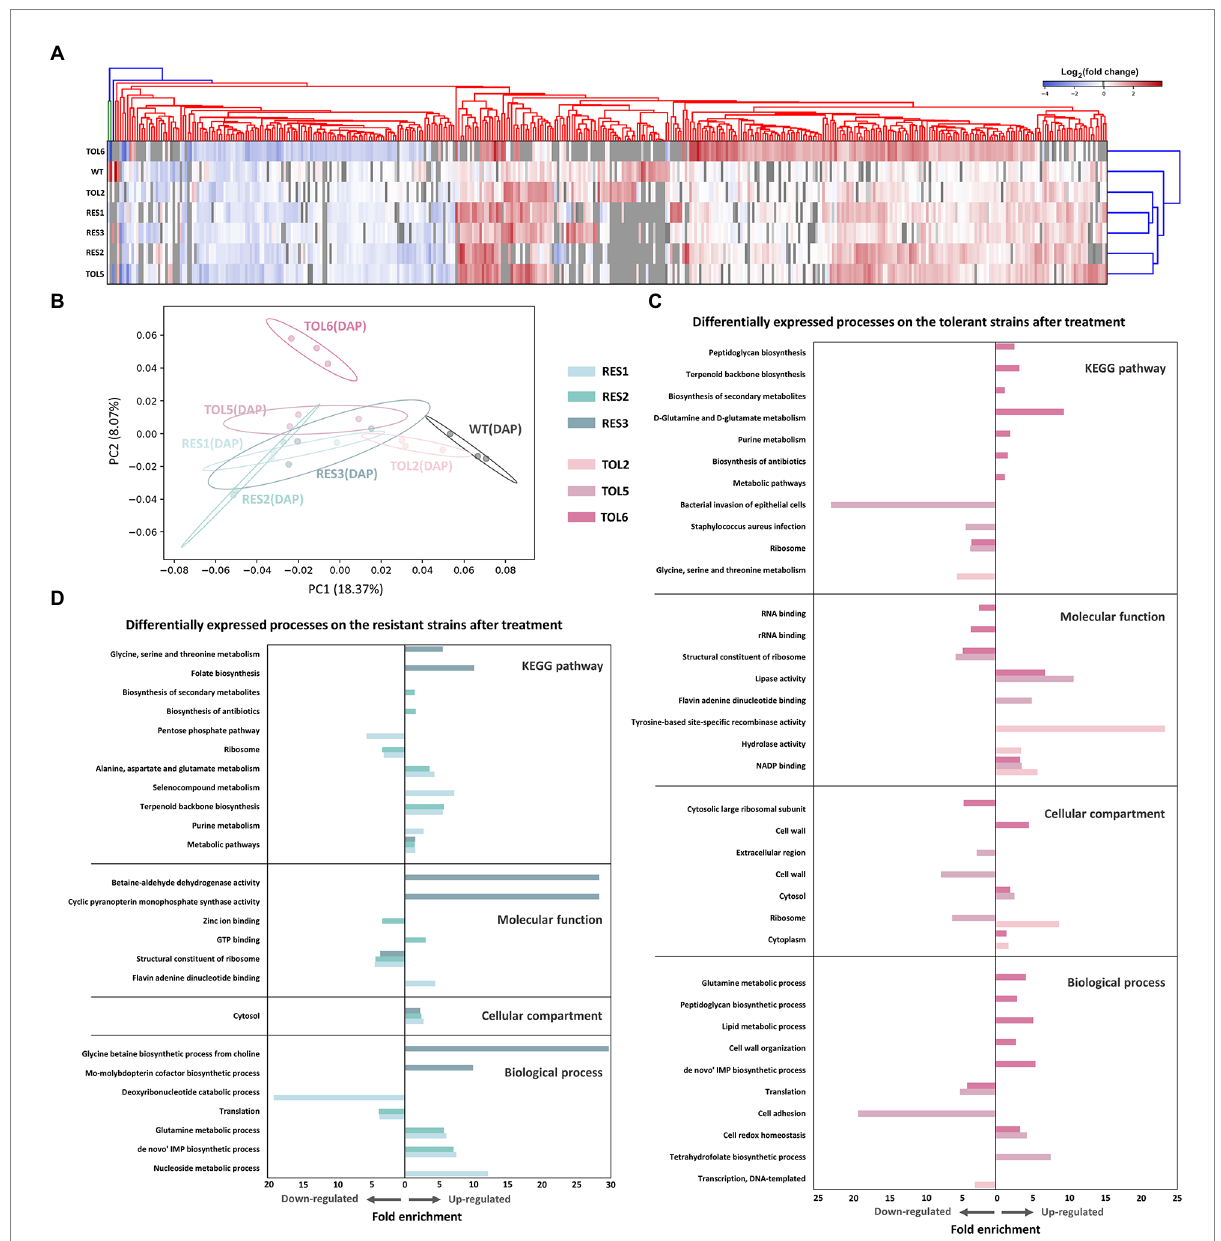
FIGURE 3 Proteomic response of the tolerant/resistant strains and the ancestral strain upon daptomycin treatment. (A) Heatmap of the DEPs across the ancestral strain, resistant strains (RES1, RES2, RES3), and tolerant strains (TOL2, TOL5, TOL6) upon daptomycin treatment compared to the untreated populations. The heatmap is clustered using average linkage hierarchical clustering based on Euclidean distances. The y-axis indicates different strains, and the x-axis represents the DEPs identified across all strains. DEPs that were undetected in specific samples are marked with gray color. (B) Principal Component Analysis (PCA) of proteomes of the tolerant/resistant strains and the ancestral strain after daptomycin treatment. Shaded circles represent 95% confidence intervals based on correlation matrices of the three replicates of each sample. (C,D) Gene Ontology (GO) analysis and pathway enrichment study (KEGG) by DAVID of the DEPs of the tolerant strains (C) and the resistant strains (D) after daptomycin treatment compared to those before treatment. Fold enrichment is defined as the ratio of the proportion of the input information to the background